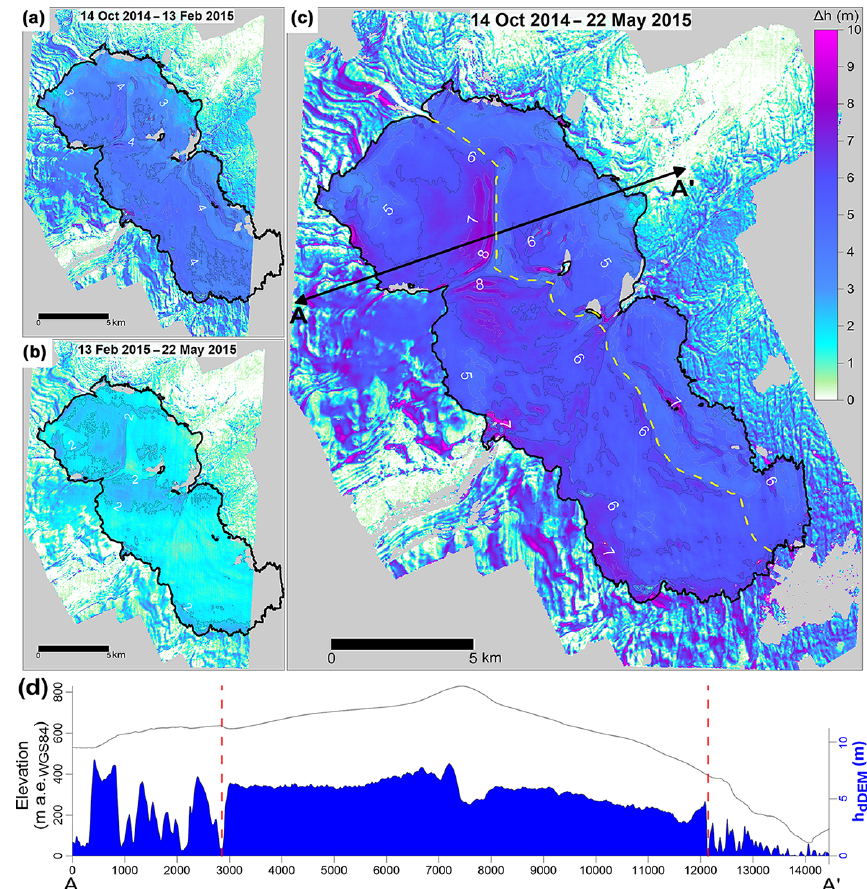
Figure 4. Elevation difference based on Pléiades and WV2 data. (a) Elevation difference from October 2014 Pléiades DEM to February 2015 WV2 DEM. (b) Elevation difference from February 2015 WV2 DEM to May 2015 Pléiades DEM. (c) Elevation difference from October 2014 Pléiades DEM to May 2015 Pléiades DEM. A black polygon indicates the glacier margin in October 2014. The yellow dashed line shows the boundary between the eastern and western halves of the ice cap. Contours on the ice cap were smoothed with a Gaussian filter of 9 × 9 window size. (d) Longitudinal profile A–A (cid:48) with surface elevation (black line, in meters above ellipsoid, ma.e.) and snow thickness (blue) over the glacier and ice-free areas. The red dashed lines indicate the location of the glacier